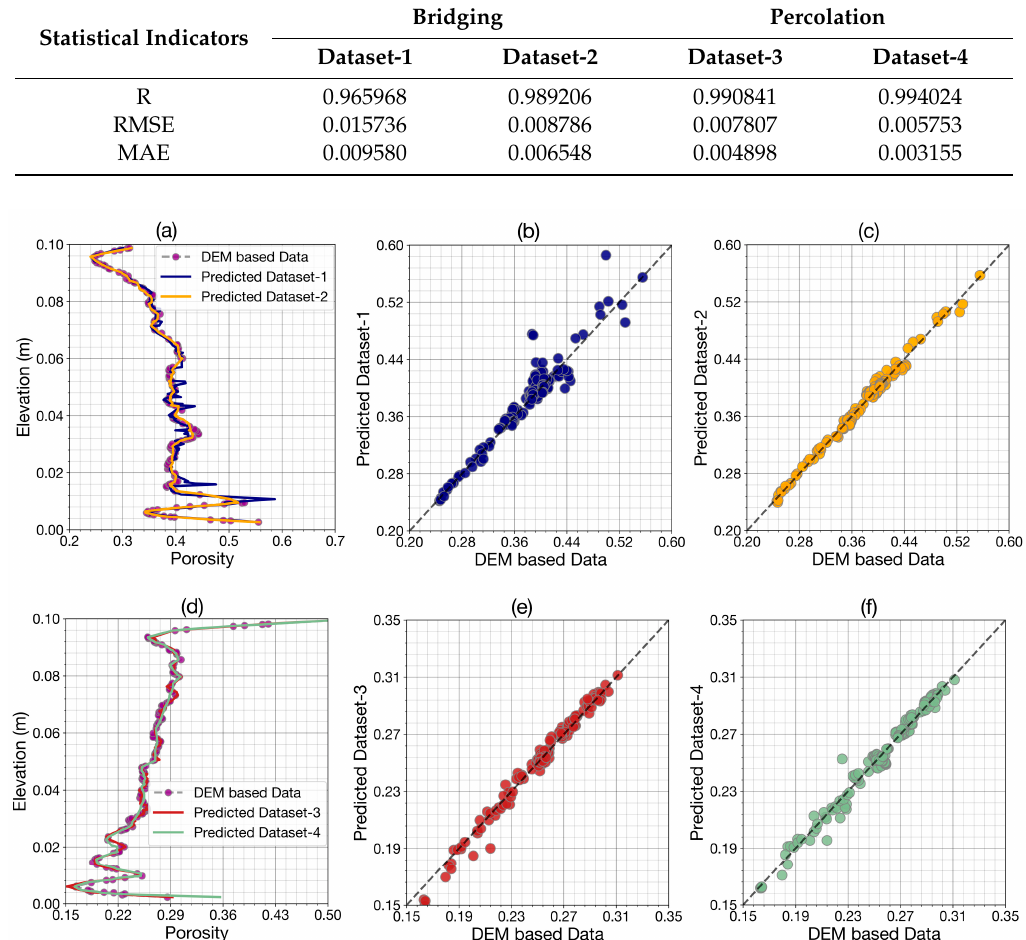
0.40 for percolation—lower panel (Figure 12b). The average oscillation amplitude of porosity for these four cases (0.18) near the sidewall varies significantly more than inside the domain (0.06). This can be partly explained because, when the distance is equal to one medium radius (0.007 m) from the wall, the center of coarse particles stack along a vertical plane parallel to the wall, where the highest density of material is reached and reduces with distance from the center of the grain. The effect of the sidewall on the increasing porosity was also discussed in the previous experimental study [41,48,49]. In Figure 12a,b, the FNN prediction based on four Datasets (5, 6, 7, and 8) gave poor results at profiles, x = 0.010 and 0.140 and some other profiles. The model did not agree with the curve of DEM based porosity distribution (e.g., x = 0.095–0.135 m). The model tends to over fit a few points with sudden increases and decreases of fine sediment due to the two sidewalls. Inversely, inside the flume when the porosity did not fluctuate significantly, the model was found to under fit. However, in general, the performances of models are in good agreement with the DEM based data. Table 6 shows relatively good results of porosity prediction and in x-direction, FNNs using Dataset-6, and Dataset-8 perform better than using Dataset-5 and Dataset-7, respectively.